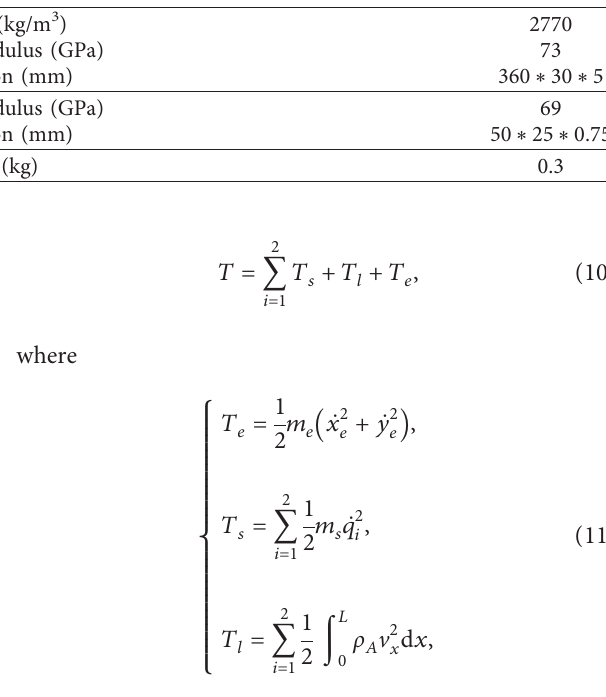
Figure 5: The kinetic energy of the flexible link. Table 1: Dynamic parameters.